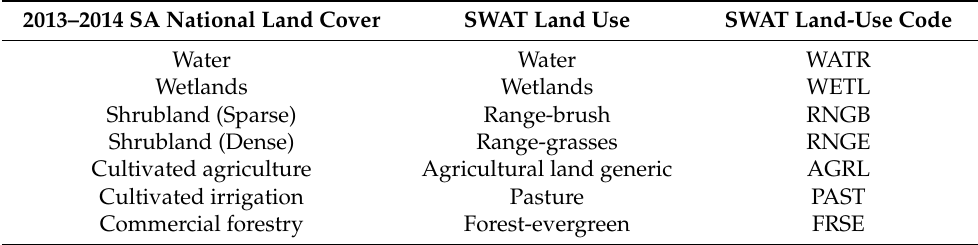
Table 1. 2013–2014 SA National Land Cover and the corresponding SWAT land-use name and